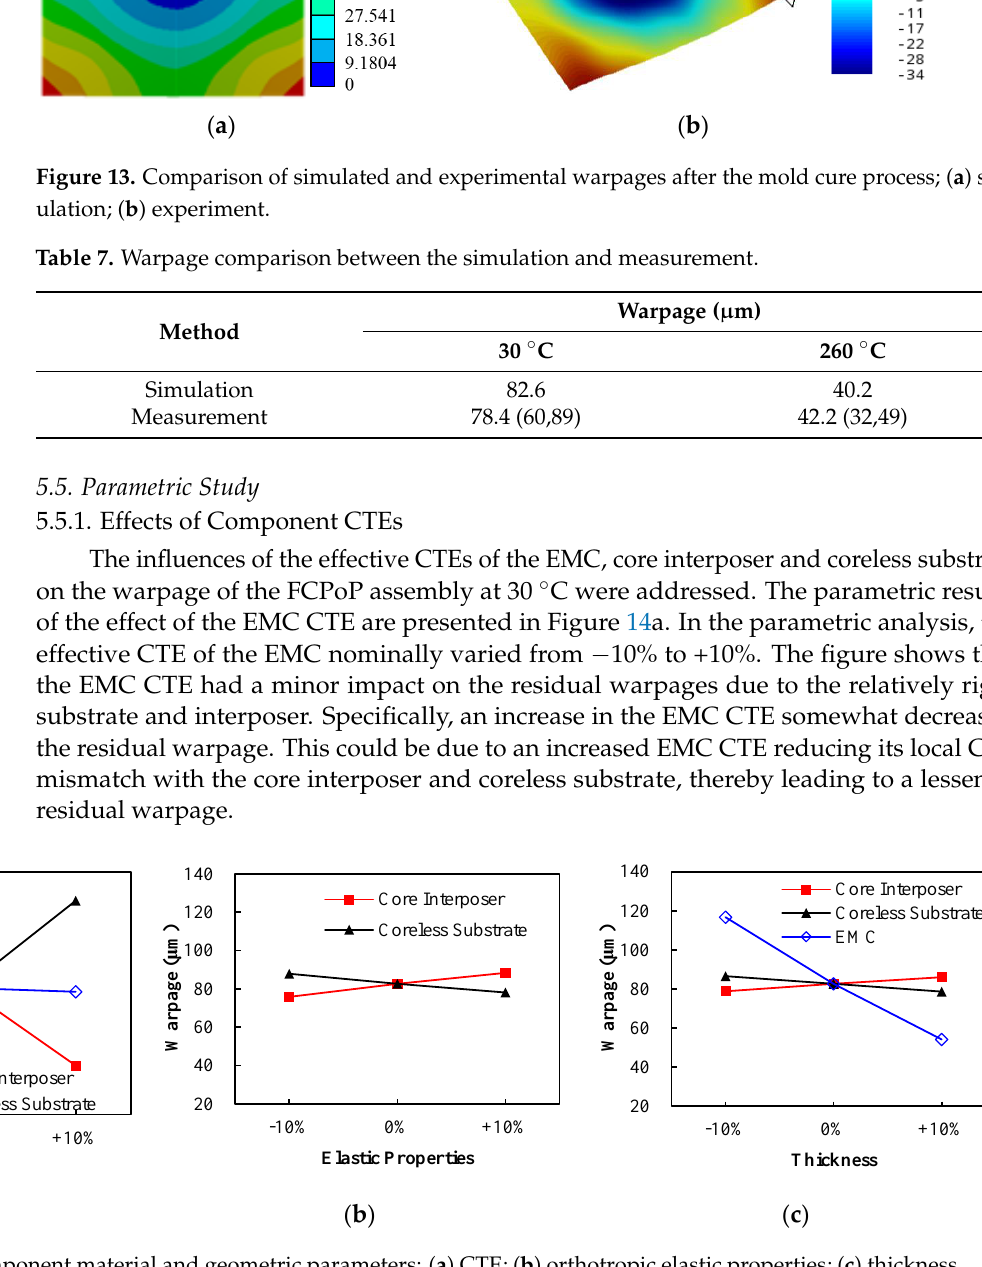
Figure 14. Effects of component material and geometric parameters: ( a ) CTE; ( b ) orthotropic elastic properties; ( c ) thick- ness.